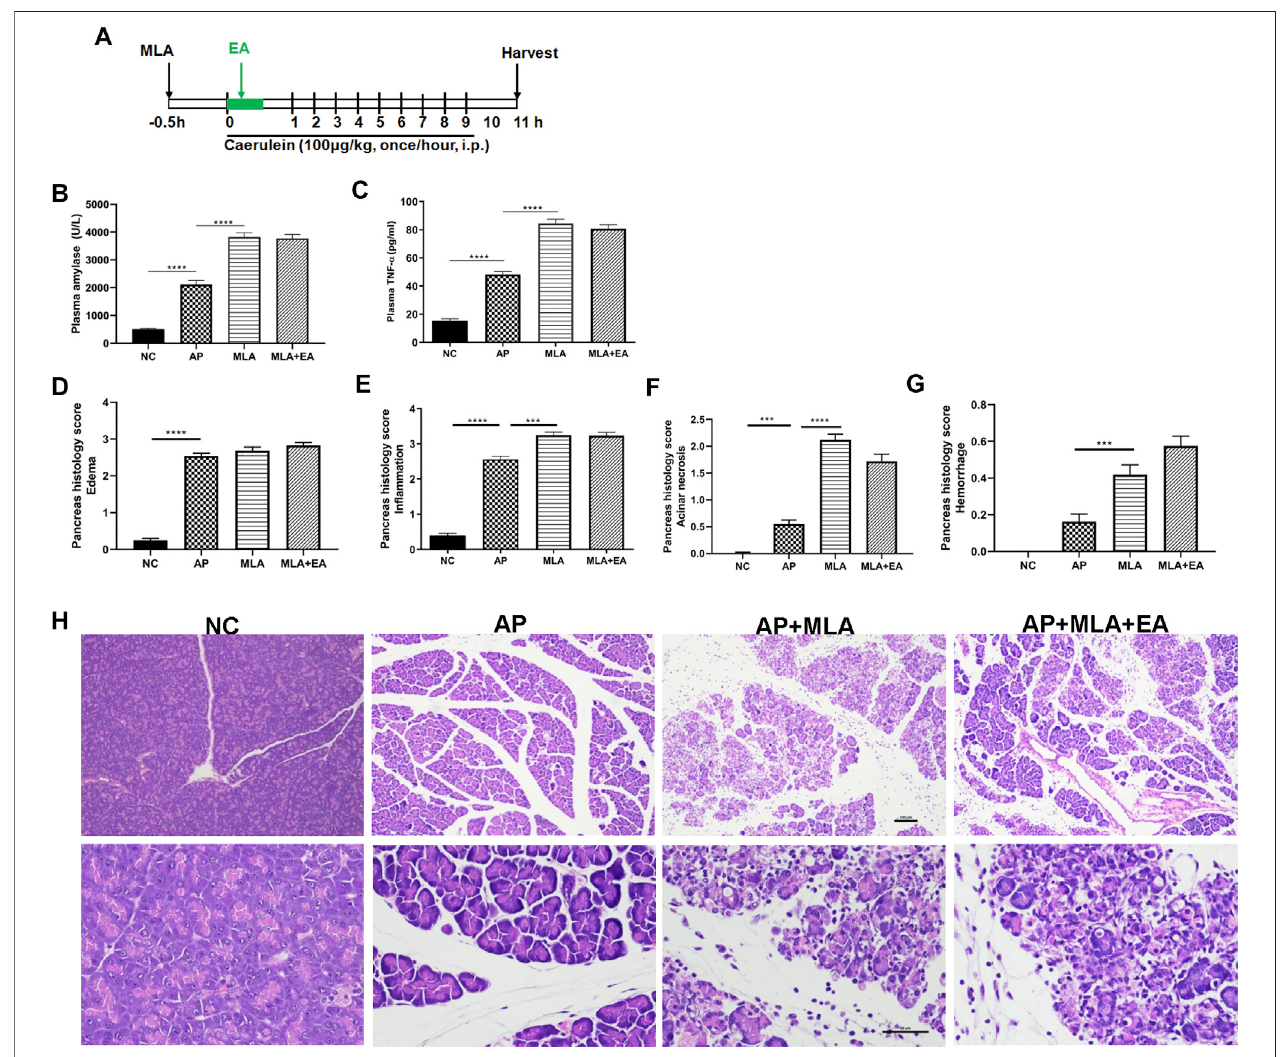
FIGURE5| TheeffectsofEAincaeruleinAPmicearemediatedthrough α 7nAChR.Methyllycaconitinecitrate(MLA,aselective α 7nAChRantagonist,3 mg/kg,i.p.) wasadministered30 minbeforethe fi rstcaeruleininjection. (A) Schematicdescriptionoftimeline. (B) Plasmaamylaseactivityat11 hafterthe fi rstcaeruleininjection. (C) Plasma TNF- α at 11 h. (D) The pancreas histological score of edema. (E) The pancreas histological score of in fl ammation. (F) The pancreas histological score of acinar necrosis. (G) Thepancreashistologicalscoreofhemorrhage. (H) RepresentativeH&Estainingofpancreassections(scalebars:100 μ m), n (cid:1) 8.Barsshowmean ± SEM. *** p < 0.001 and **** p < 0.0001. MLA, methyllycaconitine citrate; NC, normal control; AP, acute pancreatitis; EA,